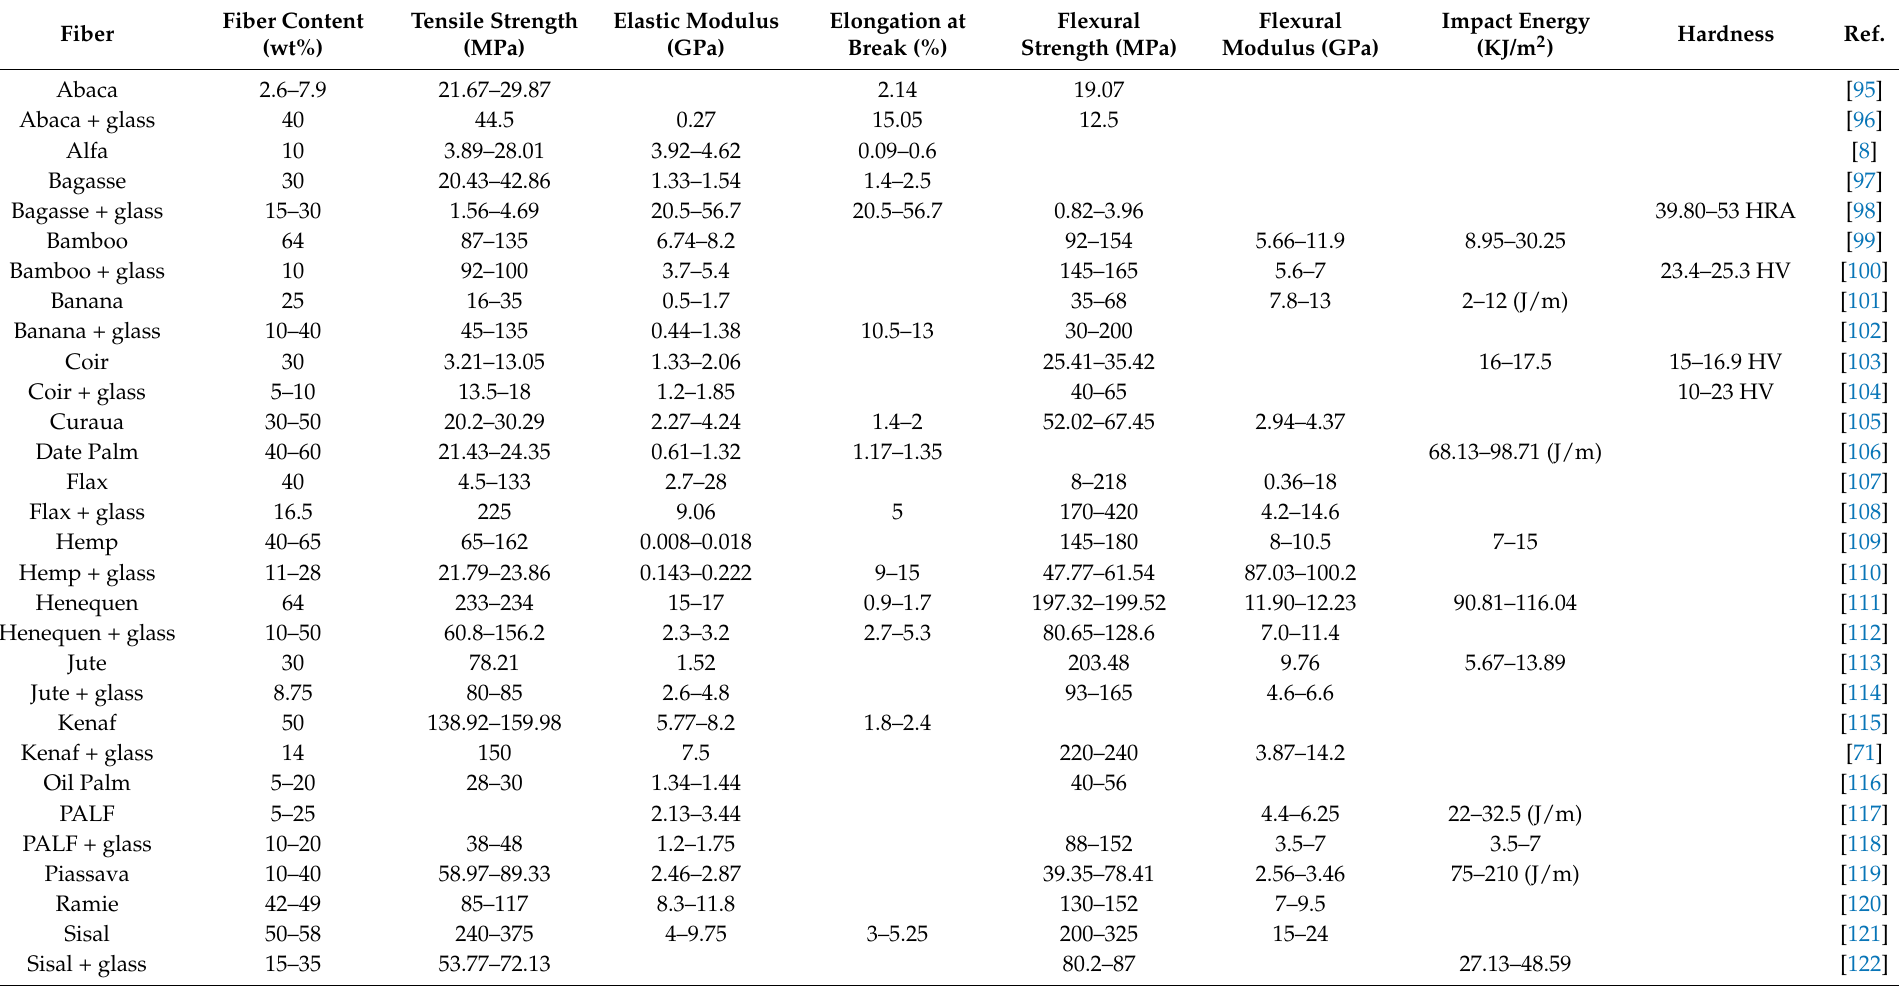
Table 1. Mechanical properties of epoxy-based natural fibers and glass hybrid polymer